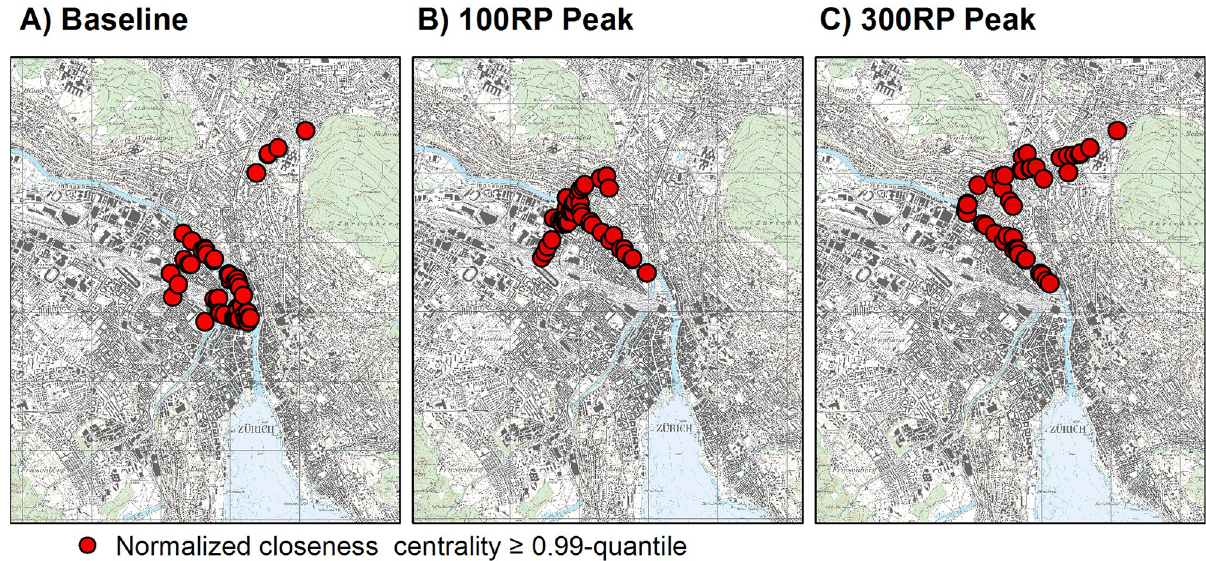
Fig 4. Spatial distribution of normalized closeness centrality for network featuring roads at least 3 m wide. Values for CC were calculated for each node, dividing by total sum of shortest-path lengths within network, and were normalized with (N-1), where N is number of nodes for given scenario. Figure presents values equal to or larger than 0.99-quantiles. Reprinted from National Map 1:25000 on sheet 1091 under a CC BY license, with permission from the Federal Office of Topography Swisstopo (original copyright 2019).